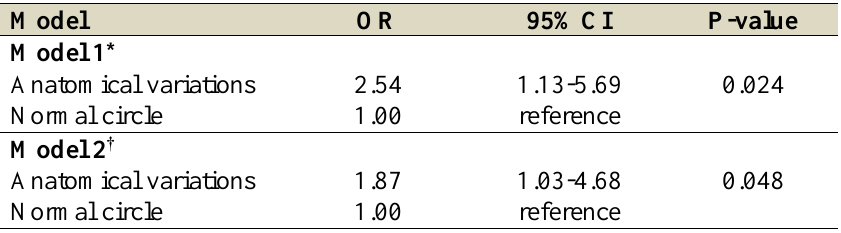
Table 3. Association of cerebrovascular accidents with the anatomical variations of the circle of Willis; odds ratios (ORs) from binary logistic